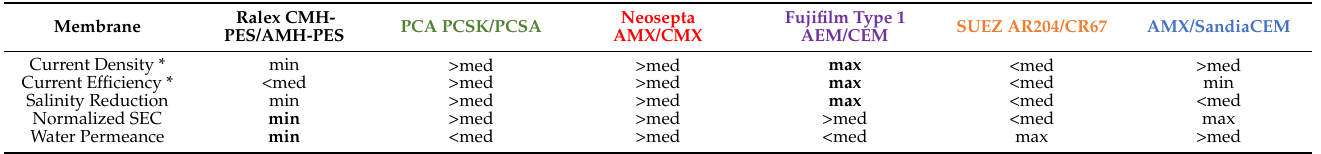
Table 3. Membrane performance